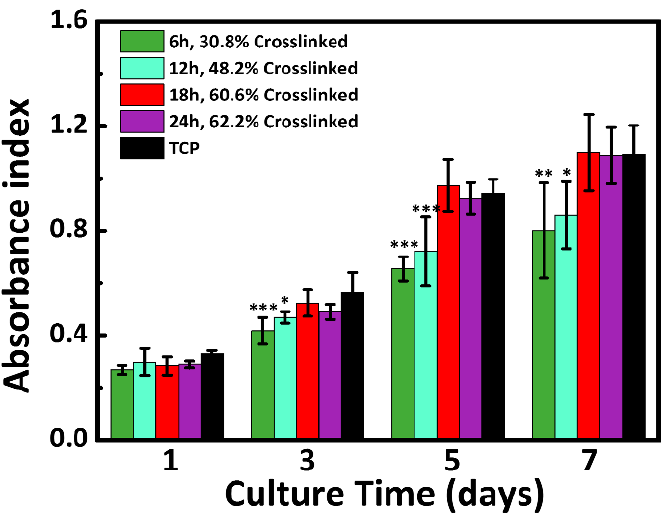
Figure 7. Comparison of cell proliferation by culturing HUVECs on the GA crosslinked electrospun membranes and the controls of Tissue culture plates (TCP) substrate (Significant differences are marked by *** for p < 0.001; ** for p < 0.01; * for p < 0.05 compared to the TCP substrate).